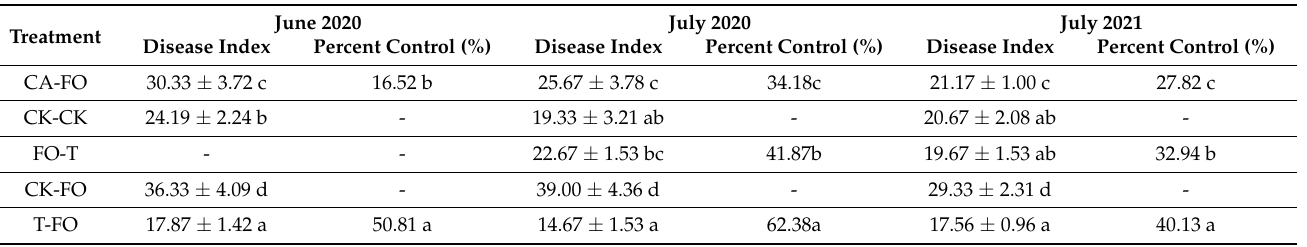
Figure 12. Control efficiency of applied T. longibrachiatum HL167 against cowpea wilt in the field trial. CA-FO (50% Carbendazim (1 g/L) + F. oxysporum ); CK-CK (fresh water + fresh water); FO-T ( F. oxysporum + T. longibrachiatum HL167); CK-FO (fresh water + F. oxysporum ); T-FO ( T. longibrachiatum HL167 + F. oxysporum ). Table 4. Disease index and percent control of applied T. longibrachiatum HL167 against F. oxysporum on cowpea root.